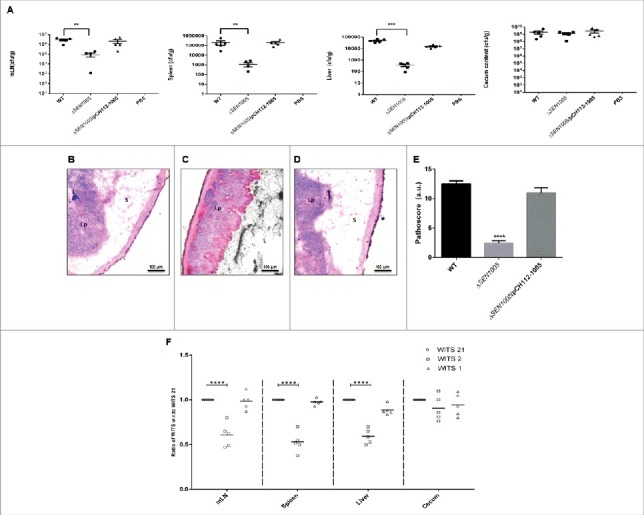
In vivo characterization of ΔSEN1005. Different groups of streptomycin-pretreated C57BL/6 mice were orally fed with ∼107cfu of WT, ΔSEN1005, ΔSEN1005/pCH112-1005 and PBS (negative control) separately. (A) Bacterial dissemination: At day 3 p.i., mice were euthanized and the bacterial load was enumerated in mLN, spleen, liver and cecum by plating on MacConkey agar. (B-D) Tissue histopathology: Hematoxylin-Eosin stained images for sections of mice cecal tissue (5µm size) from WT, ΔSEN1005 and ΔSEN1005/pCH112-1005 infected mice (left to right). Scale bar 100µm. S, submucosal edema; Lp, lamina propria; L, lumen. (E) Determination of cecal pathoscore based on the parameters described in materials and methods. (F) Assessment of competitive colonization by WITS- tagged WT (WITS21), ΔSEN1005 (WITS2) and ΔSEN1005/pCH112-1005 (WITS1). Mice were infected with equal proportions of each strain with a total inoculum pool of ∼107 cfu. At 72h p.i., the mice were sacrificed and their mLN, spleen, liver and cecum were collected and homogenized. The genomic DNA was isolated from each organ and the bacterial load of each strain was enumerated by qRT-PCR using WITS specific primers. The data was expressed as the ratio of WITS with respect to WITS21. Number of mice (n) = 5 for each group. Statistical significance: *P < 0.05, **P < 0.01, ***P < 0.001, ****P< 0.0001 (Student's t-tests for Fig. 3A and 3E; Two-way ANOVA for Fig. 3F).